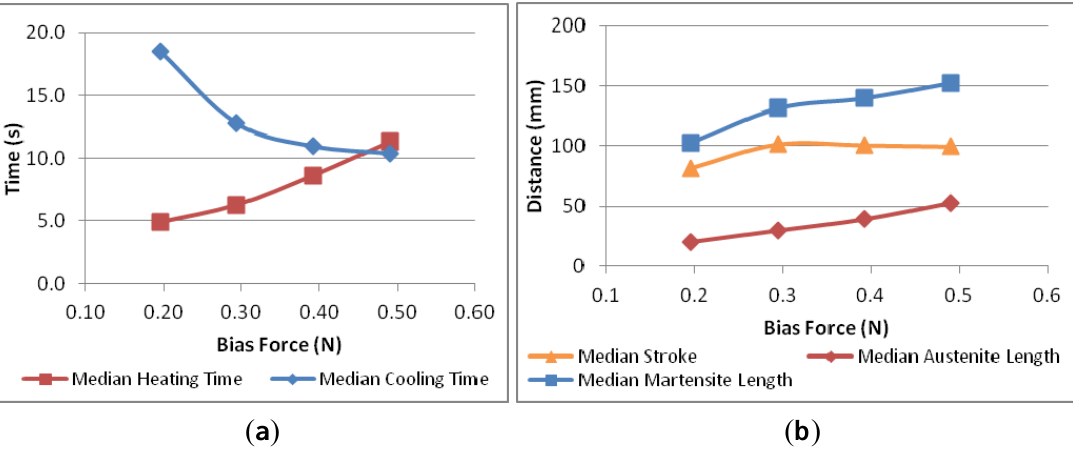
Figure 6. Experimental results from the bias force manipulation. ( a ) (Left) The averaged heat and cooling times. ( b ) (Right) The averaged strokes, martensite lengths and austenite